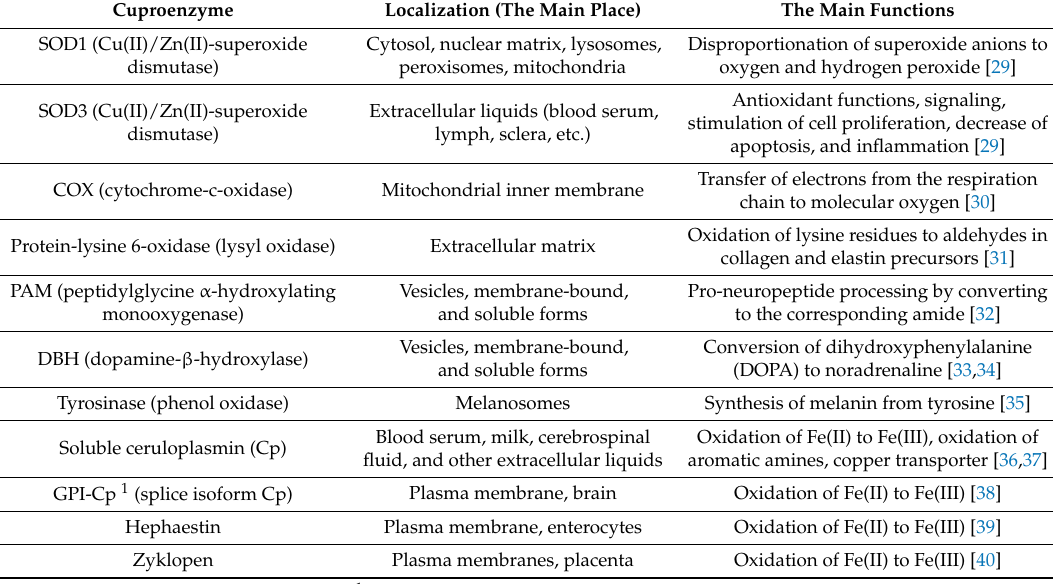
Table 1. The main mammalian